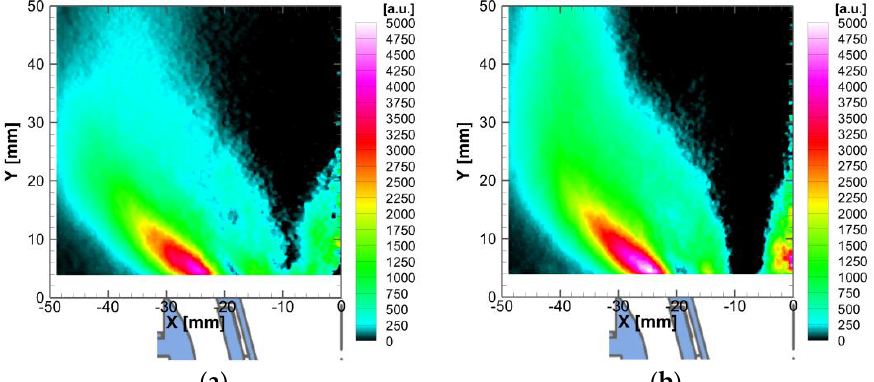
Figure 17. Deconvoluted OH* distribution under cruise conditions: ( a ) case P and ( b ) case M. (Illustration of the burner exit section is superimposed beneath the horizontal axis).